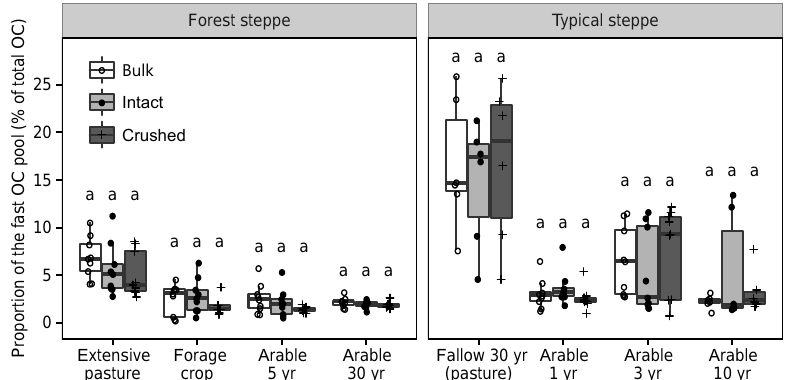
Figure 4. Proportion of the fast OC pool (% of total OC) for eight plots within two steppe types and for the three fractions bulk soil, intact macro-aggregates, and crushed macro-aggregates as derived from two-pool model fits to incubation data (Eqs. 2 and 3). Significant differences ( p < 0 . 05) between fractions within plots were not detected, which is indicated by same lowercase